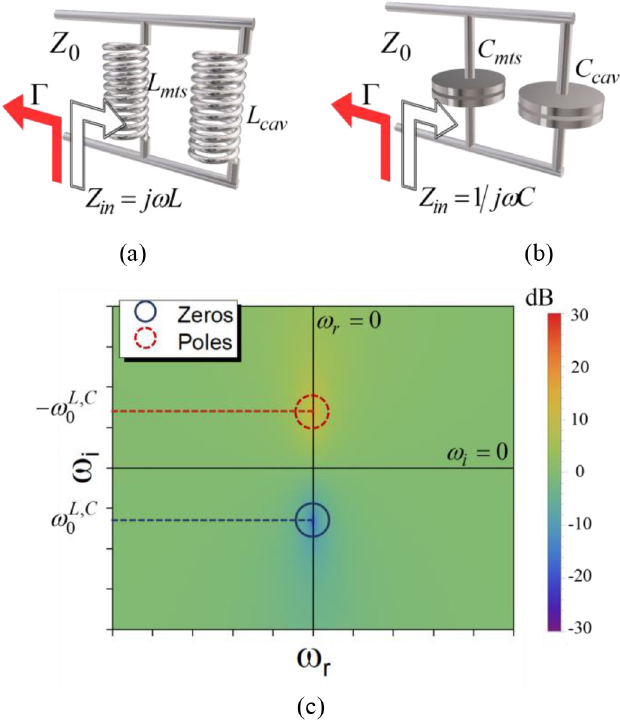
Fig. 2. Parallel connection of two reactances with the same electrical behaviour (a) both inductive and (b) both capacitive. (c) Amplitude of the re fl ection coef fi cient of the loaded transmission line in the complex frequency